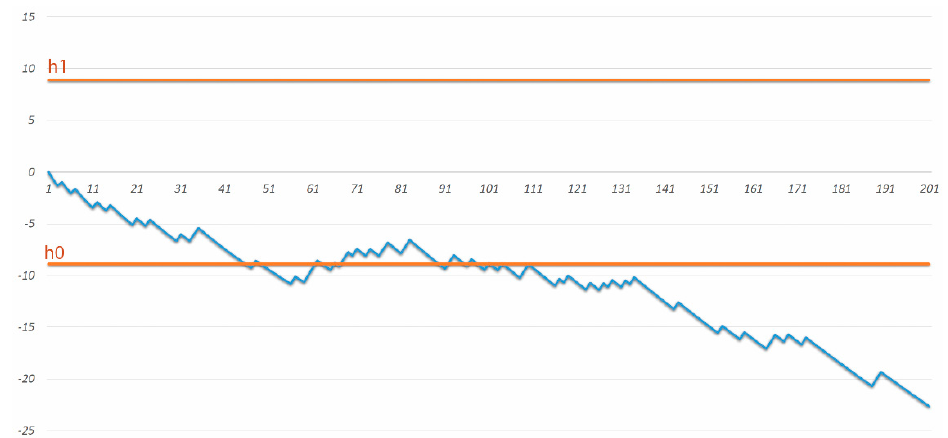
Figure 2. Risk-adjusted sequential probability ratio test (RA-SPRT) chart for complications according to the Clavien–Dindo classification. The x-axis represents the operation number. The y-axis represents a cumulative log-likelihood ratio value.